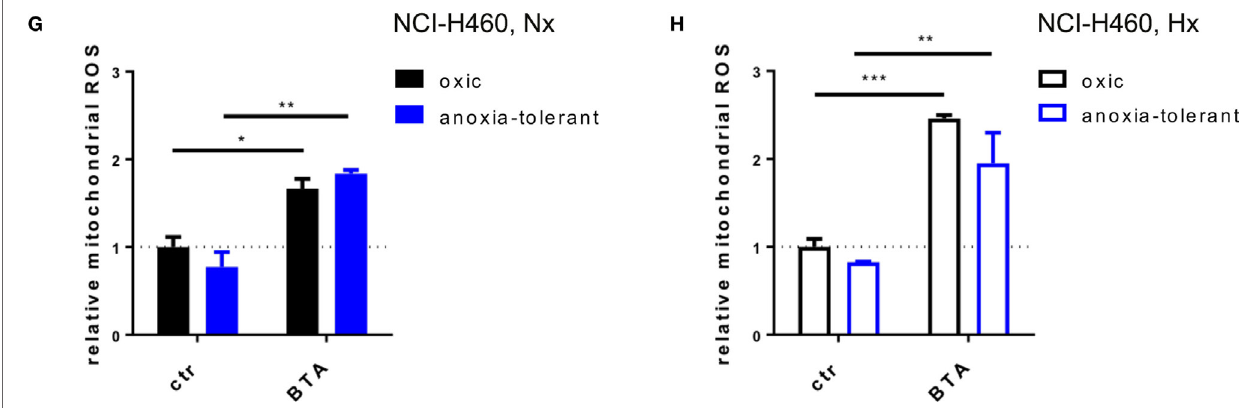
FigUre 4 | Inhibition of SLC25A1 disturbs cellular and mitochondrial redox homeostasis. NCI-H460 oxic and anoxia-tolerant cells were treated with 5 mM BTA in normoxia (Nx, 20% O 2 ) or upon preincubation for 2 h in acute severe hypoxia (Hx, 0.2% O 2 ) and antioxidant capacity and ROS formation were determined 2 or 6 h after treatment in functional assays. (a) Impact of BTA treatment on total NADPH levels (NADPH + NADP + ) under normoxic (Nx) conditions as determined by using a luciferase-coupled enzymatic reaction 2 h after treatment. (B) Impact of BTA treatment on total NADPH levels (NADPH + NADP + ) under Hx conditions. (c) NADP + / NADPH ratio upon 2 h of BTA treatment under Nx conditions. (D) NADP + /NADPH ratio upon 2 h of BTA treatment under Hx conditions. (e) Influence of BTA treatment on GSH levels under Nx conditions as measured by fluorescence of monochlorobimane (MCB) 2 h after treatment. (F) Influence of BTA treatment on GSH levels under Hx conditions. (g) Mitochondrial superoxide reactive oxygen species (ROS) as determined in flow cytometry by staining with MitoSox 6 h after treatment under Nx conditions. Fold changes of gated positive cells are indicated. (h) Mitochondrial ROS as determined in flow cytometry by staining with MitoSox 6 h after treatment under Hx conditions. Mean values ± SEM are shown, n = 3. (ns p > 0.05, * p ≤ 0.05, ** p < 0.01, and *** p ≤ 0.001; two-way ANOVA with Tukey